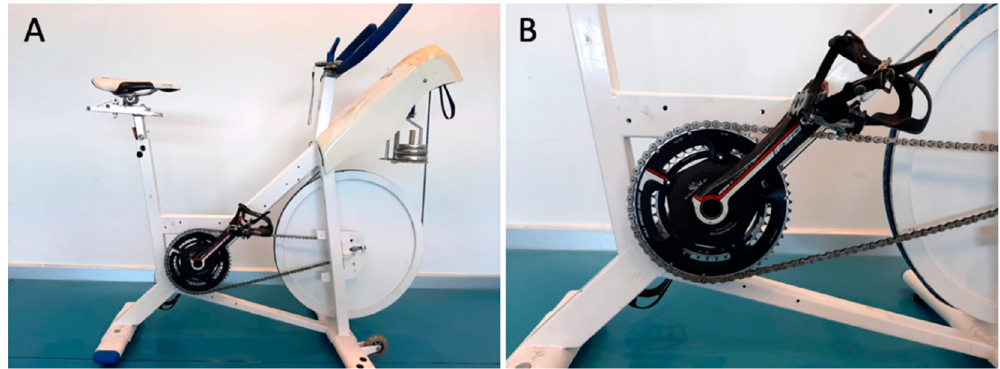
Figure 1. SRM ® power meter (Panel B ) adapted to the Monark ® friction belt cycle ergometer (Panel A ). This technology obtained the power variable (force × velocity) multiplying the strain gauge deformation on the shafts of both cranks (force) by the revolution per second registered through reed switch triggers (velocity).